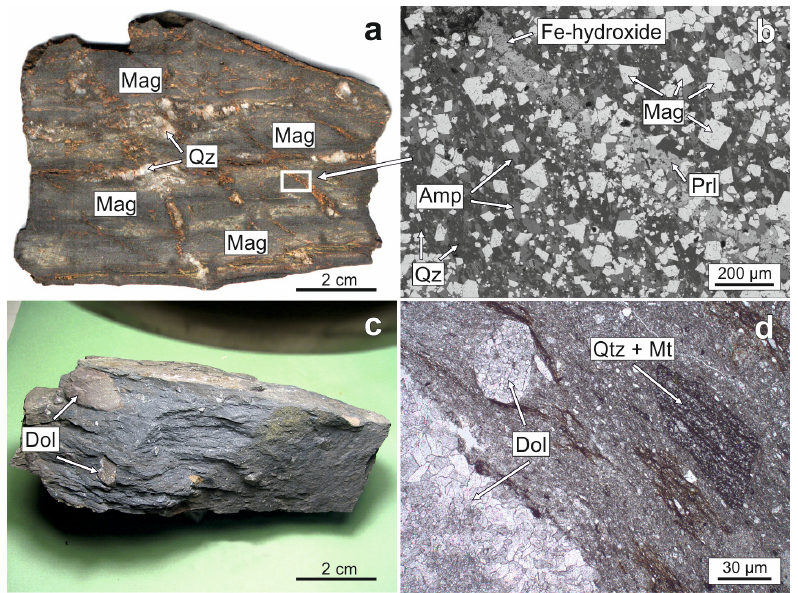
Figure 4. Iron-oxide ore ( a , b ) and explosive breccia ( c , d ) from the Kostenga deposit. ( a , c )—hand specimens, ( b )—SEM image, ( d )—thin section microphotograph. SEM images here and through-